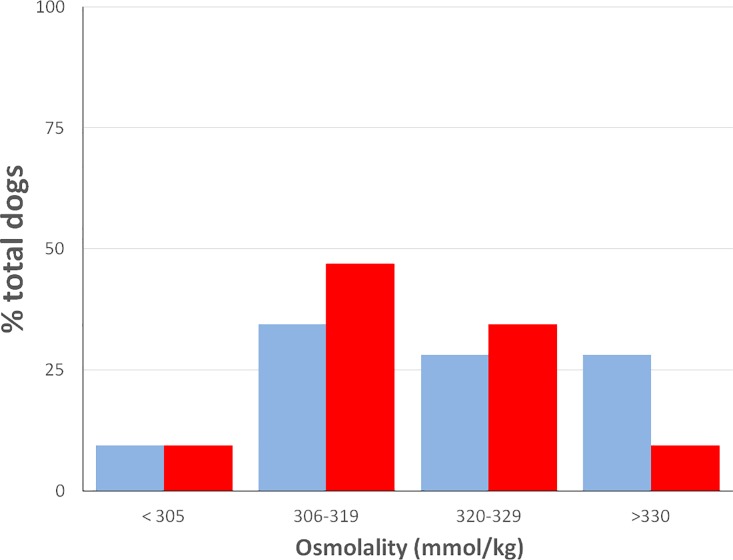
Classification of dogs by serum osmolarity or serum tonicity.Classification of diabetic dogs as having normal tonicity (< 305 mmol/kg), mild hypertonicity (305–319 mmol/kg), moderate hypertonicity (320–329 mmol/kg), and severe hypertonicity (≥ 330 mmol/kg) using serum total measured osmolality (blue bars) or calculated tonicity (red bars). The effect of urea and other ineffective osmoles on total osmolality results in overestimation of the prevalence of severe hypertonicity in diabetic dogs.